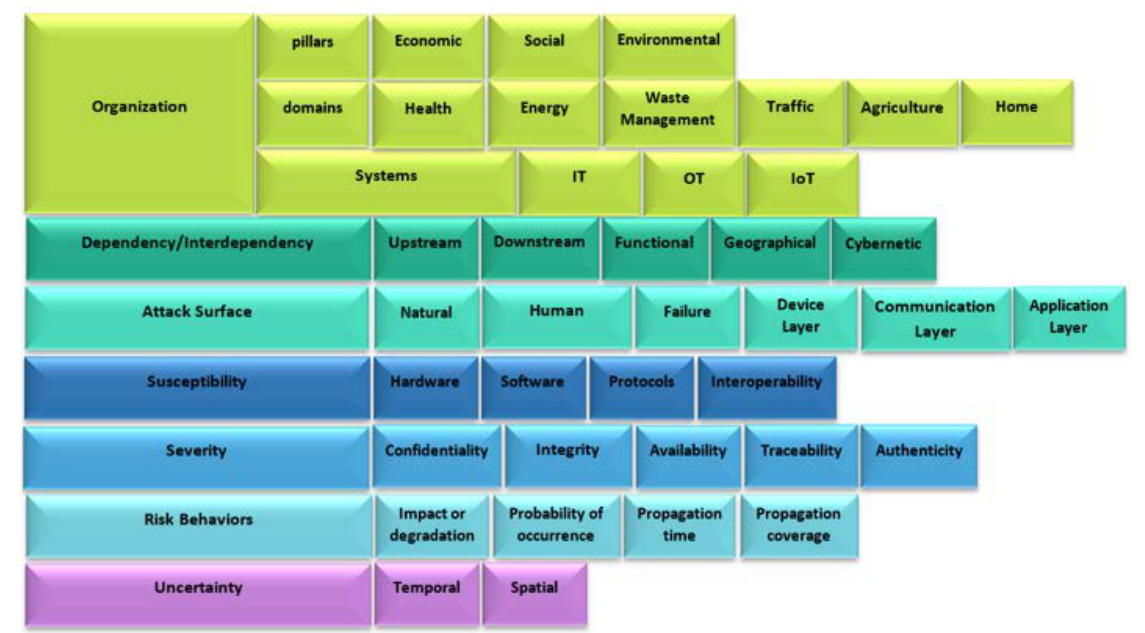
Figure 20. Framework of security risk components of IoT systems.